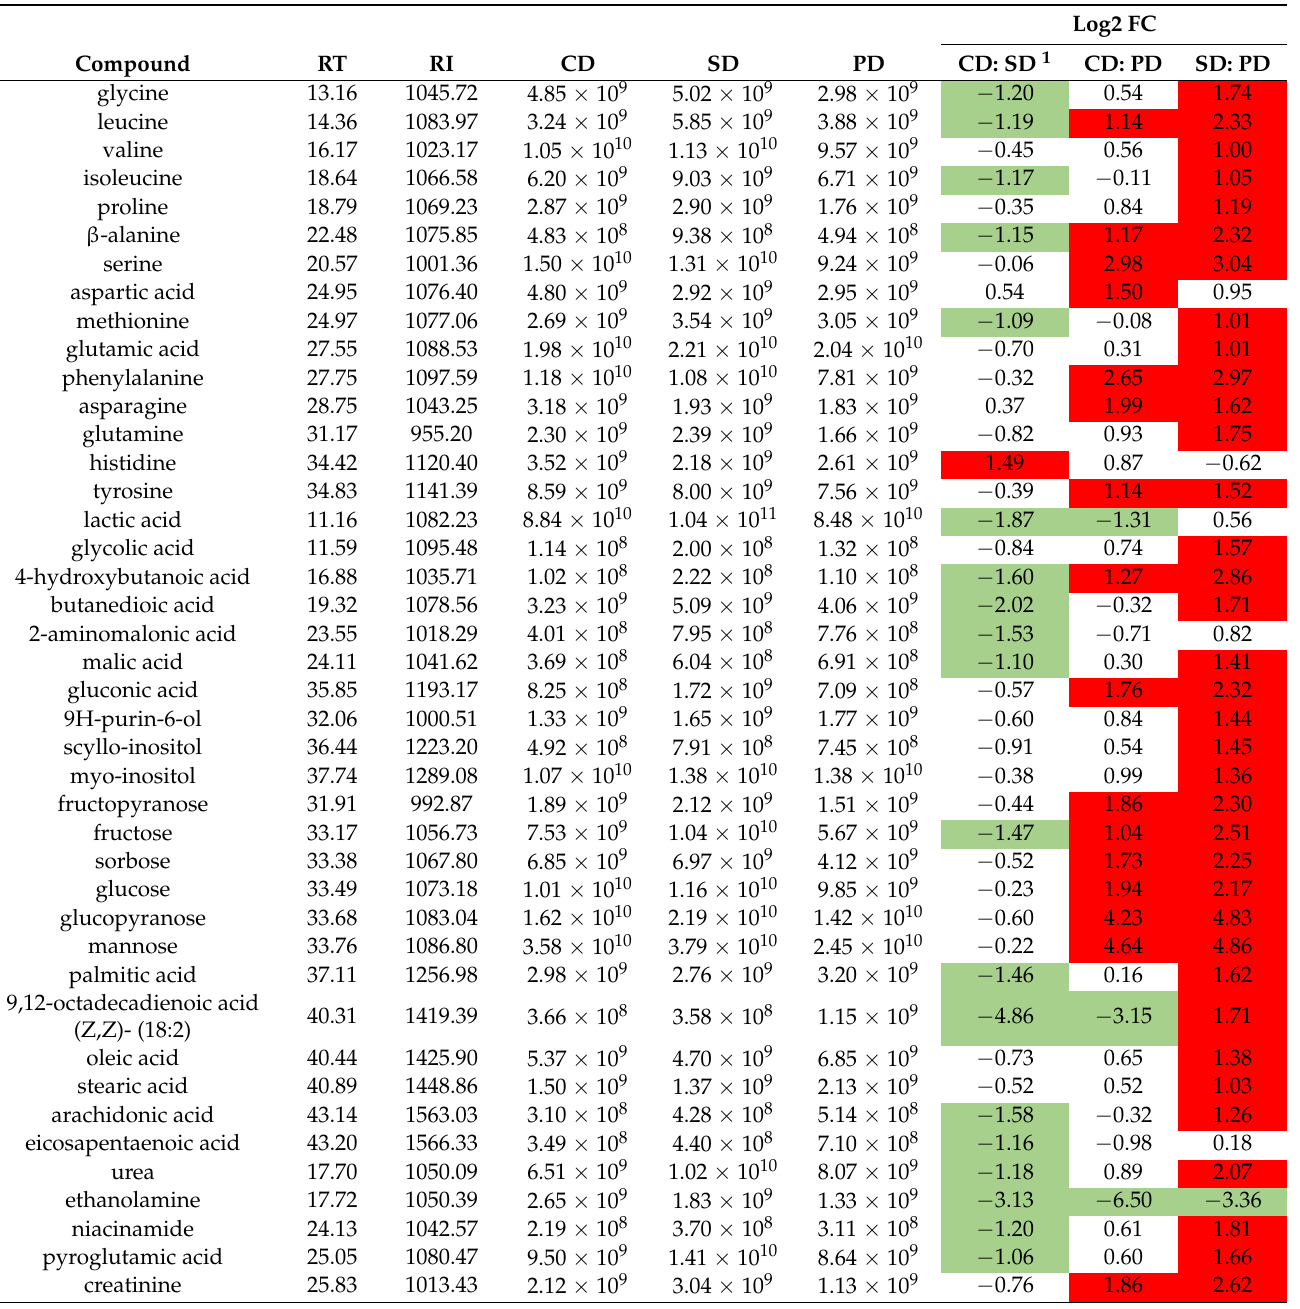
Table 5. Metabolite profile of dry-cured leg and variations of the metabolites between the three lamb finishing diets (Log2 Fold change values, Log2